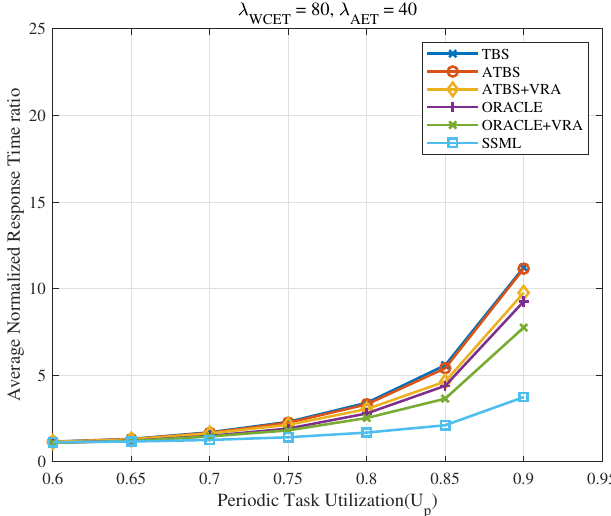
Figure 5. Comparison of average normalized response time ratio according to different periodic task utilization when the exponential distribution average of WCET and actual execution times are 80 and 40,